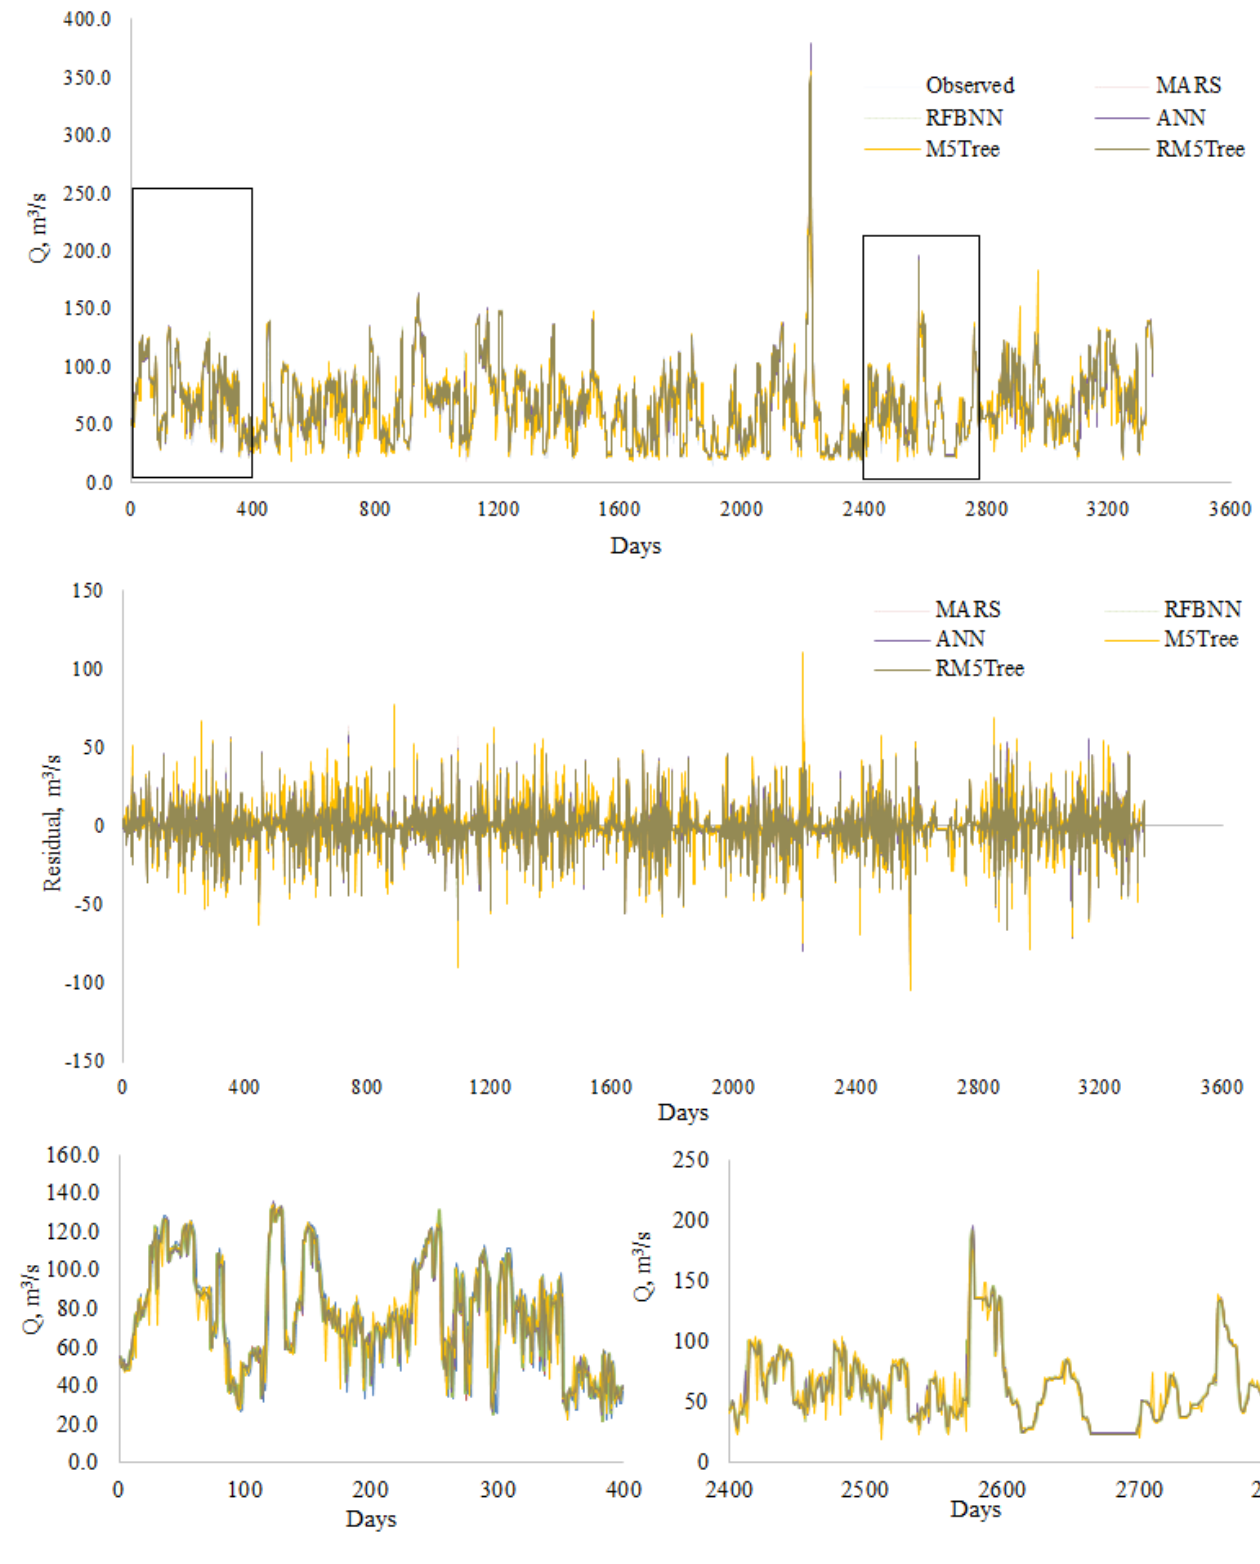
Figure 5. Time variation graphs of the observed and predicted streamflow by RM5Tree, M5Tree, RBFNN, ANN, and MARS models in the test period of Ostavallselet Station (upstream).